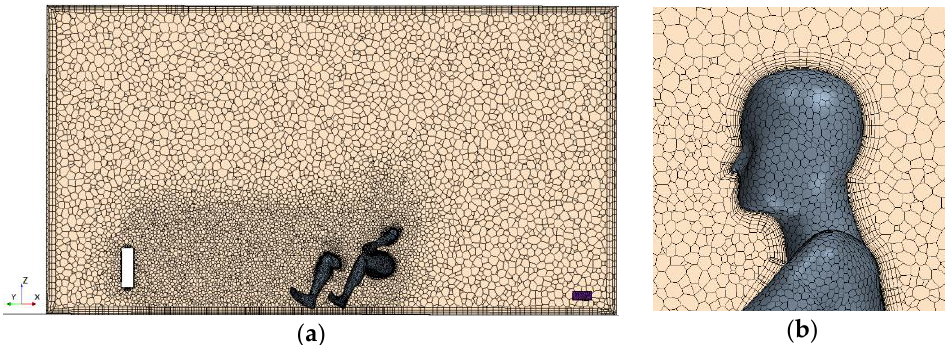
Figure 16. Mesh sections ( a ) through the manikin, fan, and chamber and ( b ) prism layers around the manikin.